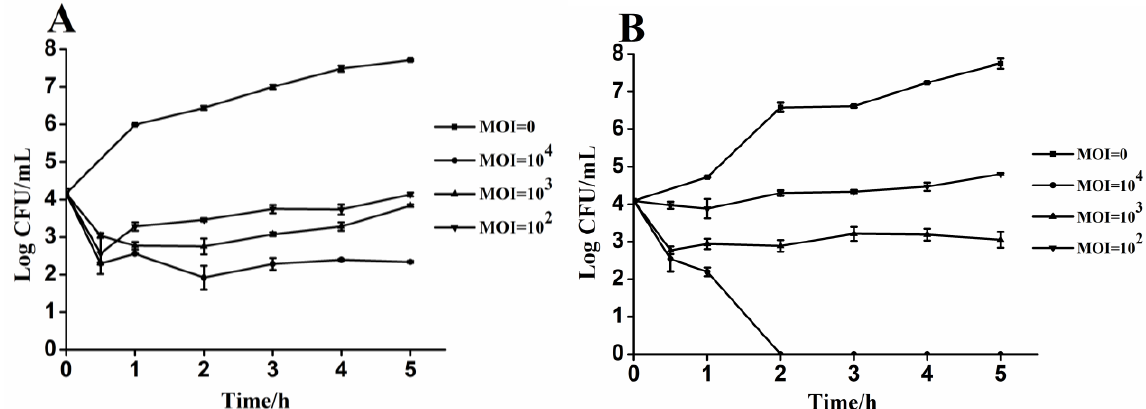
Figure 3. Lytic effects of phage PA13076 and PC2184 against the specified hosts of liquid cultures in vitro : ( A ) PA13076 and ( B ) PC2184.